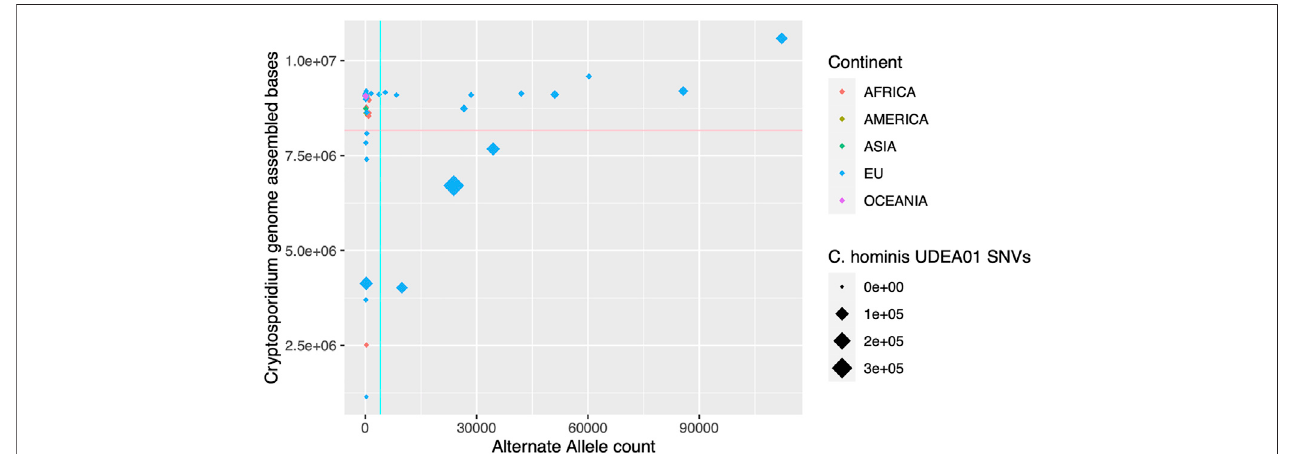
FIGURE 2 | Graphical representation of the de novo assembled C. hominis genome size and alternate allele detection. In the x-axis, alternate allele count for each genome. In the y-axis, Cryptosporidium assembly size in bases pairs. The continent where the parasite was isolated is represented in colors. The size of the rhombus depicts the single nucleotide variants (SNVs) counts against the C. hominis UDEA01 genome reference. The cyan and pink lines indicate the thresholds established for low-quality genomes, alternate allele count (cid:1) 3,992, and assembled genome size (cid:1) 8,166,447 bases,